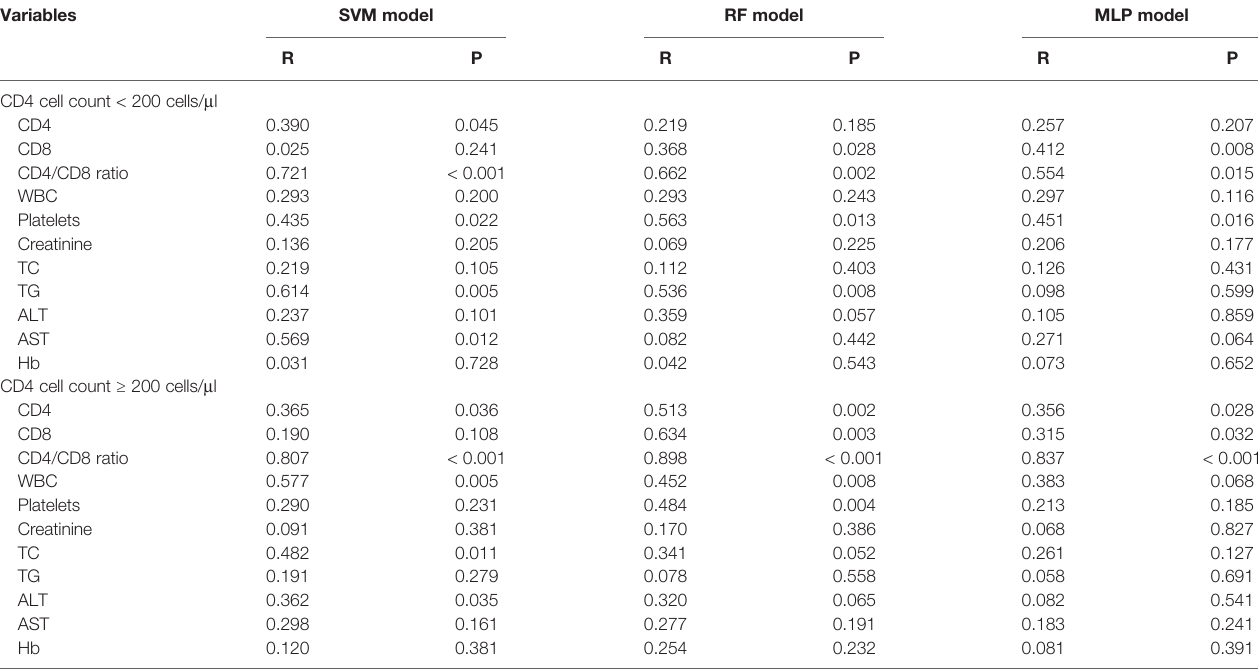
Pearson correlation statistics are displayed as correlation coef fi cients (R) and P